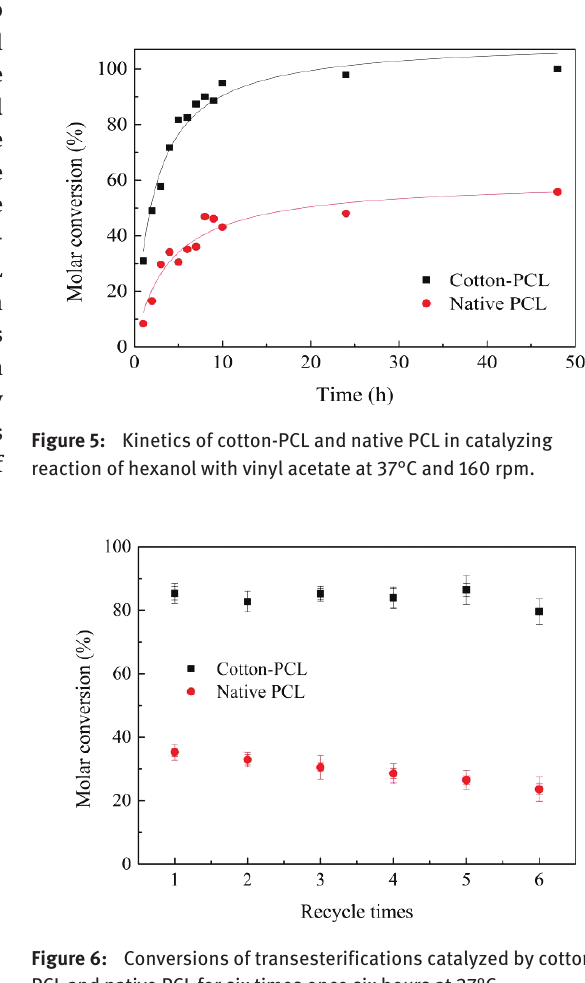
Figure 6: Conversions of transesterifications catalyzed by cotton- PCL and native PCL for six times once six hours at